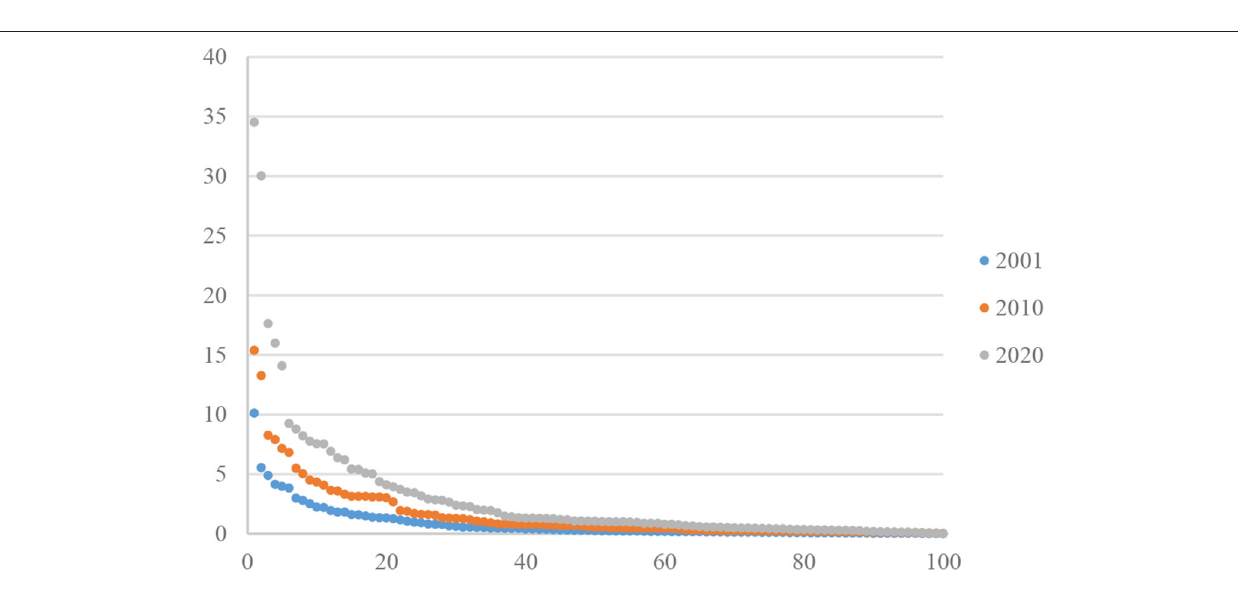
FIGURE 3 | Rank-node degree distribution of global TCM trade